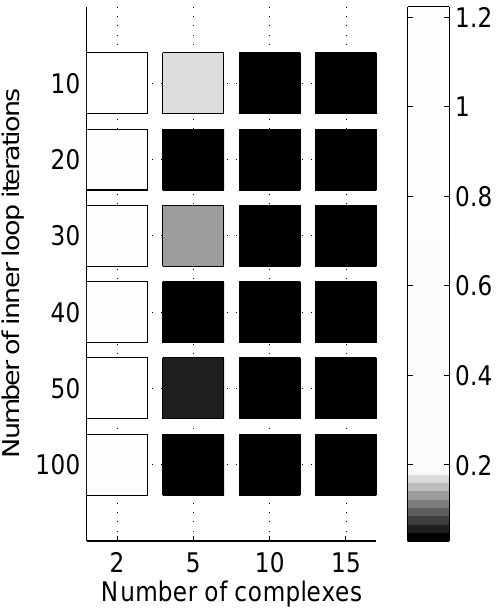
Table 3: Descriptive statistics of the performance of differ-